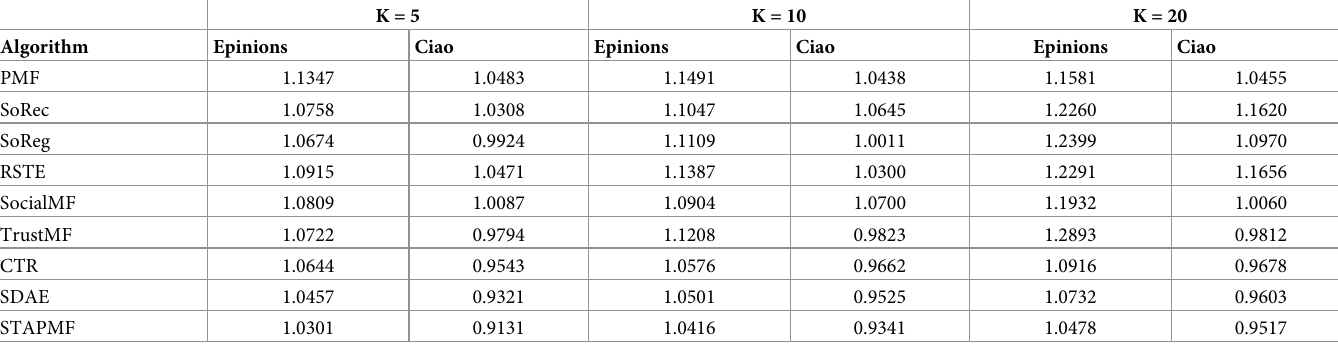
Table 2. RMSE comparisons for different